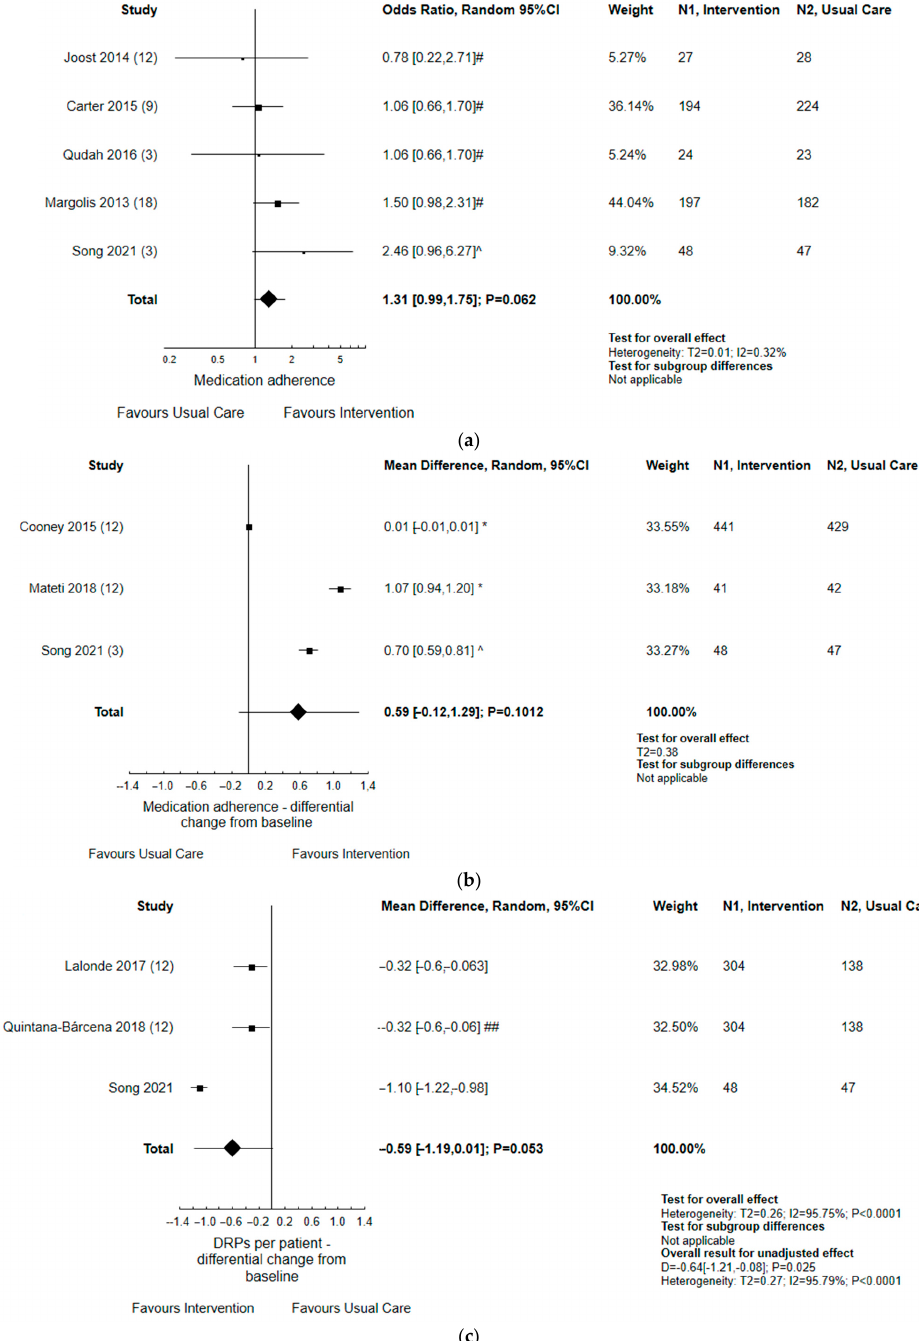
Figure 5. Forest plot of comparison: pharmacist contribution to comprehensive intervention vs. usual care for continuous and dichotomous data concerning medication adherence ( a , b ); DRPs per patient ( c ); #—patients with good adherence, defined as 0 (1), according to 4-item Morisky Medication Adherence Scale (MMAS) score; ˆ—patients with increased 6-item MMAS score; *—patients with increased 8-item MMAS score; ##—adjusted for the number of drug related problems (DRPs) at baseline, the interaction between study group and number of DRPs at baseline, and for patient’s age, sex, highest level of education, and eGFR, as well as for pharmacists’ being an associate clinician and receiving remuneration for pharmaceutical opinions; months of follow-up were shown in brackets